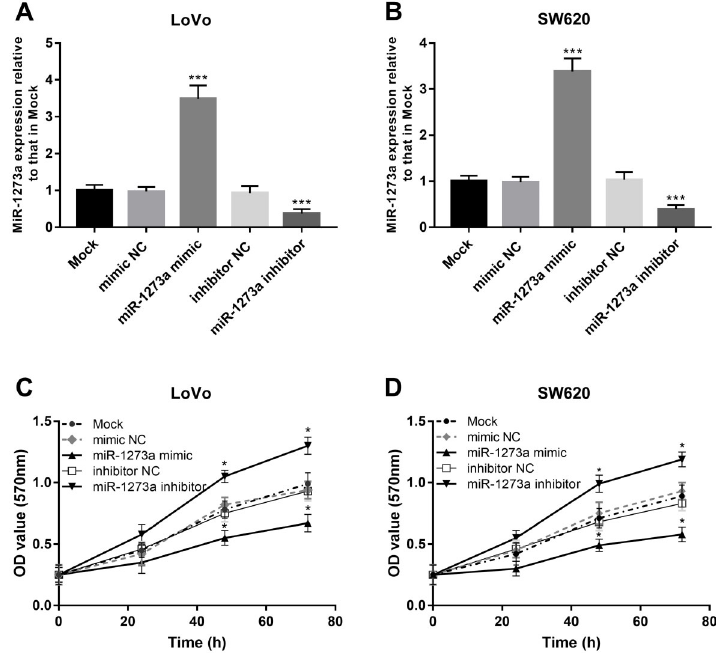
Figure 3. The expression of miR-1273a in ( A ) LoVo and ( B ) SW620 cell lines was signi fi cantly promoted by miR-1273a mimic, while it was signi fi cantly repressed by miR-1273a inhibitor compared with the untreated cells. The proliferation of both ( C ) LoVo and ( D ) SW620 cells was signi fi cantly promoted by miR-1273a downregulation, whereas it was signi fi cantly suppressed by miR-1273a upregulation. Data are reported as means ± SD. *P o 0.05, ***P o 0.001 (ANOVA followed by Tukey ’ s test). NC: negative